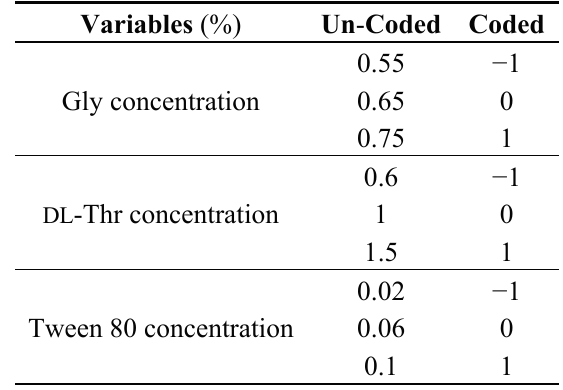
Table 7. Coded and un-coded values of the